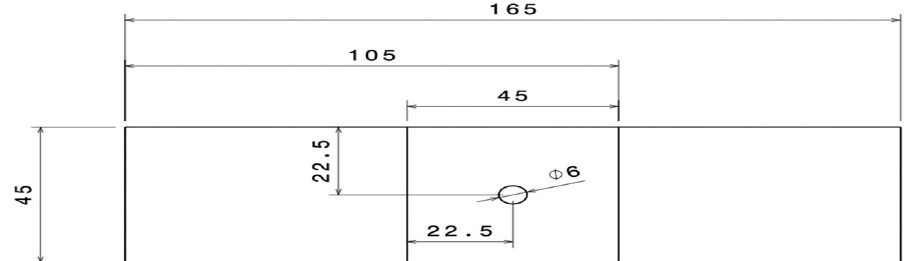
Figure 7: Spot welding specimen